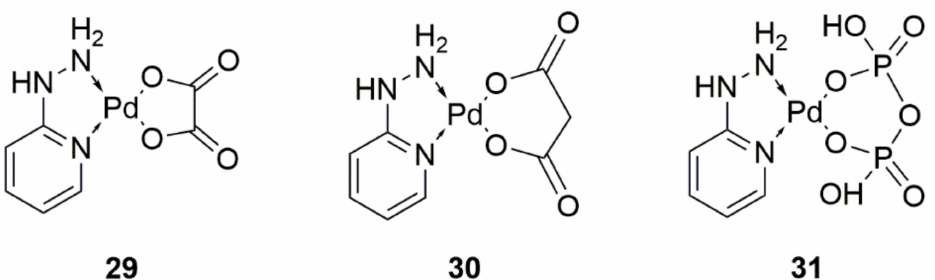
Figure 13. Structures of palladium(II) complexes with 2-hydrazinopyridine conjugated with ( 29 ) oxalate, ( 30 ) malonate, and ( 31 ) pyrophosphate ligand.